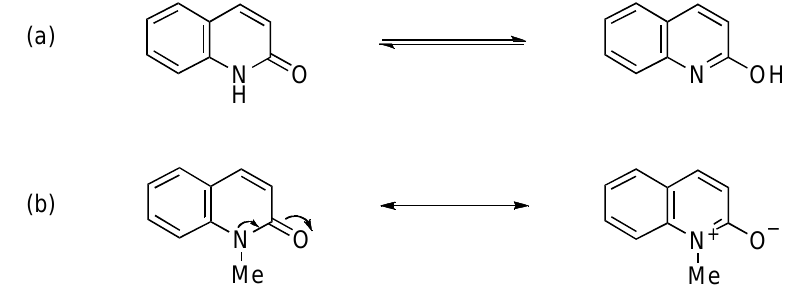
Figure 1. (a) Tautomerism of 2-quinolone. (b) Resonance structures of 1-methyl-2- quinolone